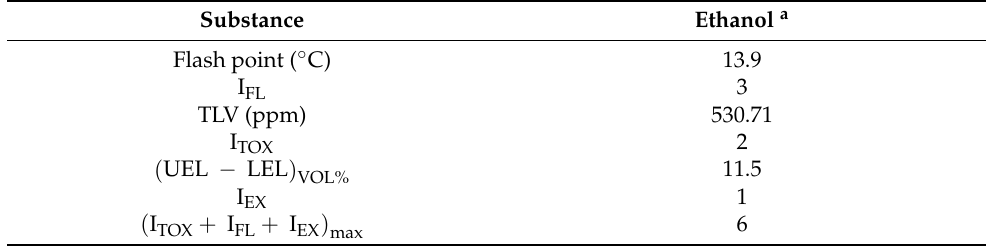
Table 3. Safety parameters for dangerous substances.